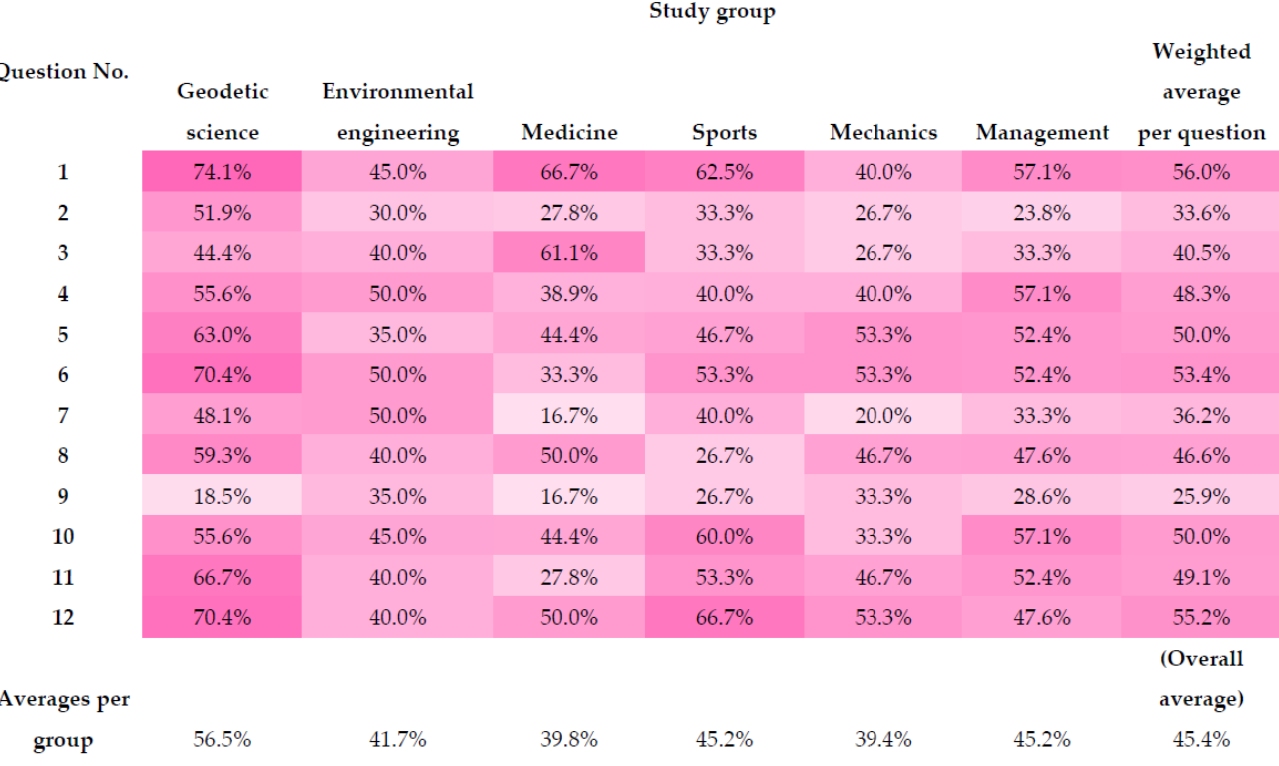
Figure 7. Differences (men-women) between the percentages of correct answers given by men and women to questions 1 – 12 overall and in the study groups, provided in percentage points.